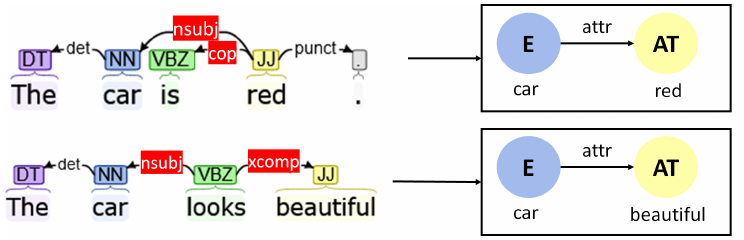
Figure 8. Various ways to indirectly extract “attr” edges from